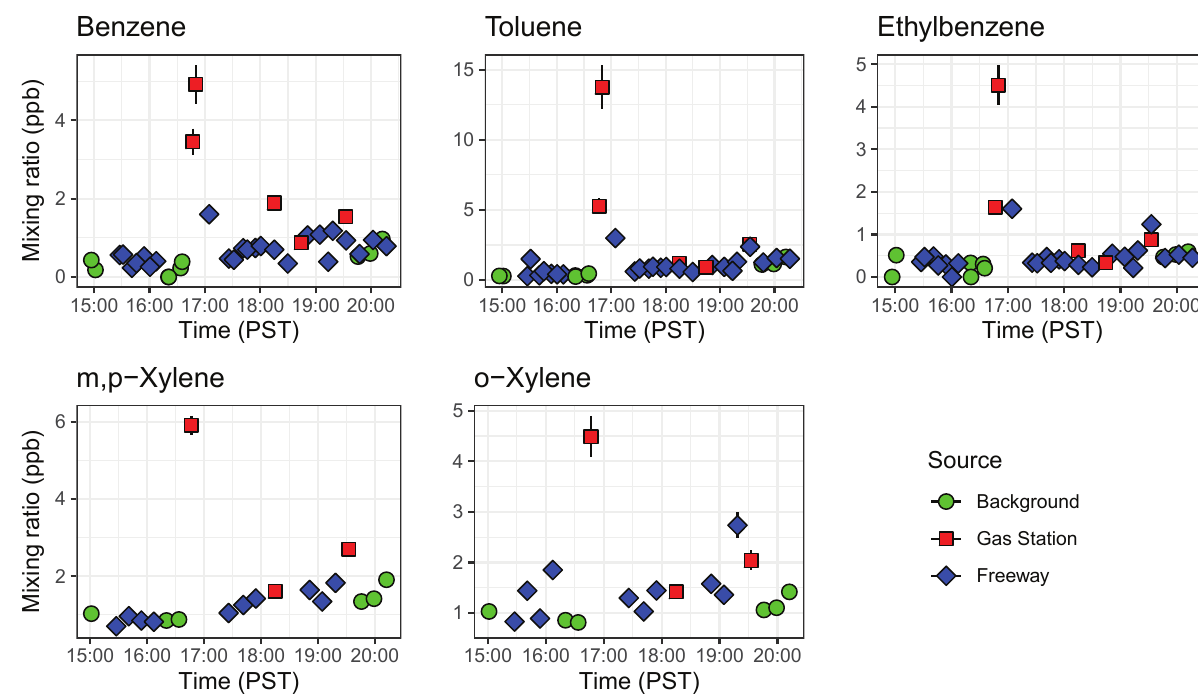
Figure 10. Timeseries of BTEX compounds detected by both GC1 and GC2 abroad a mobile platform before rush hour (15:00 to 16:00 PST) and during the afternoon rush hour (16:00 to 20:00 PST). These results show the portability of the compact GC-PID for mobile applications. Error bars represent error propagated from instrument